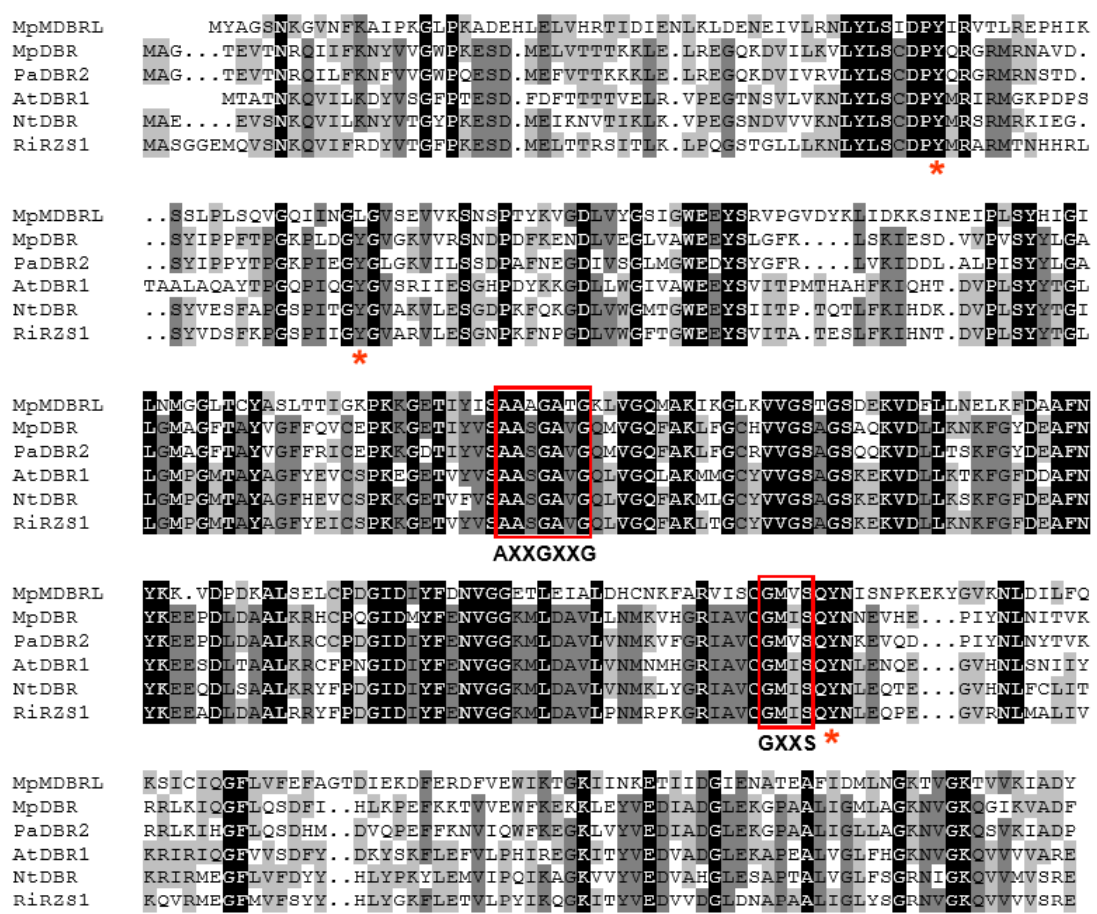
Figure 1. The peptide alignment of MpDBR and MpMDBRL with other double bond reductase sequences. PaDBR2 from Plagiochasma appendiculatum , AtDBR1 from Arabidopsis thaliana , NtDBR from Nicotiana tabacum and RiRZS1 from Rubus idaeus . Identical residues are shown in black and similar ones in gray. The conserved co-enzyme binding motifs AXXGXXG and GXXS are shown boxed, and active site residues indicated with an asterisk.